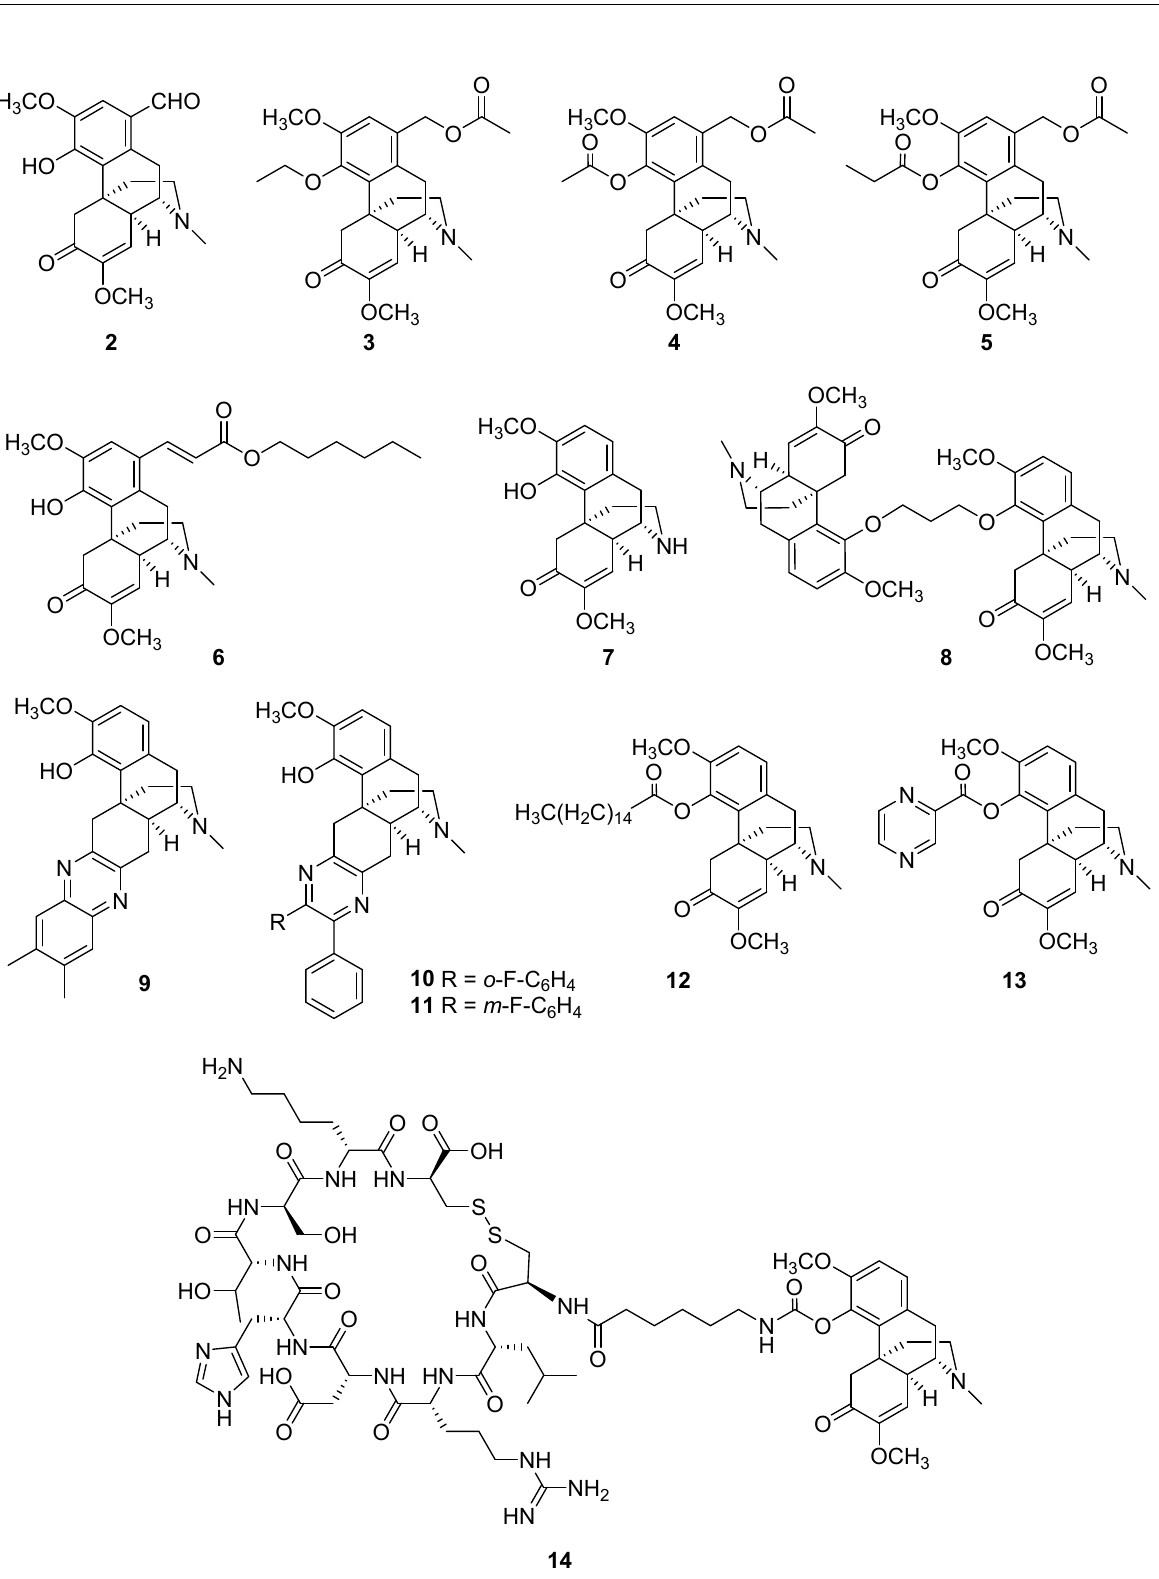
Figure 3. Structures of promising anti ‐ RA sinomenine ‐ based derivatives and conjugates.